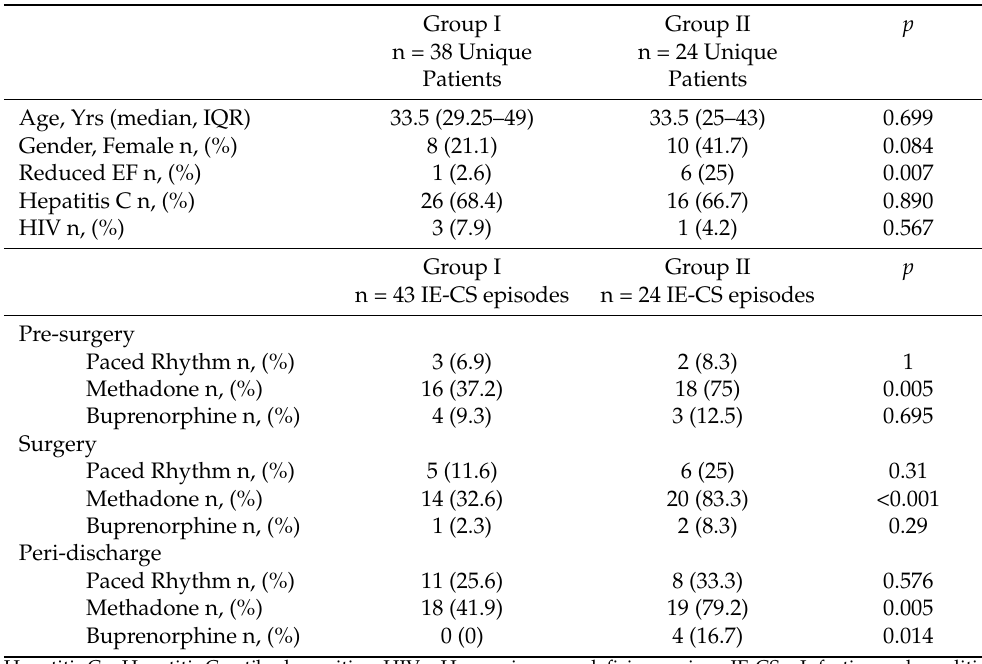
Table 1. Characteristics of Groups I and